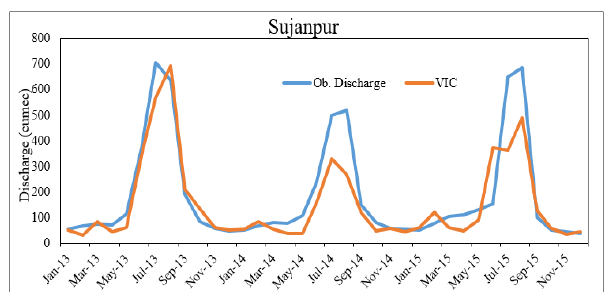
Figure 12 Validation plot of Simulated and observed Discharge at Sujanpur The above plot shows that the simulated discharge follows